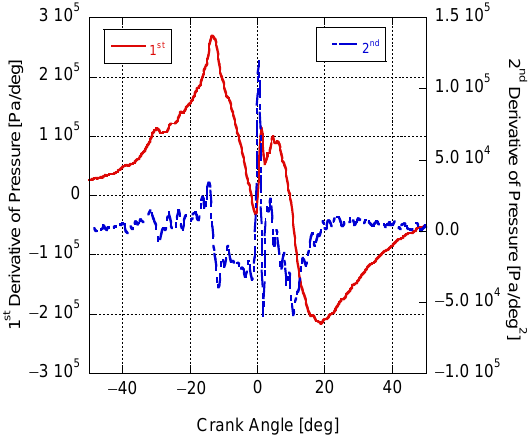
Figure 2. The first and second derivatives of pressure based on the filtered pressure as a function of crank angle.